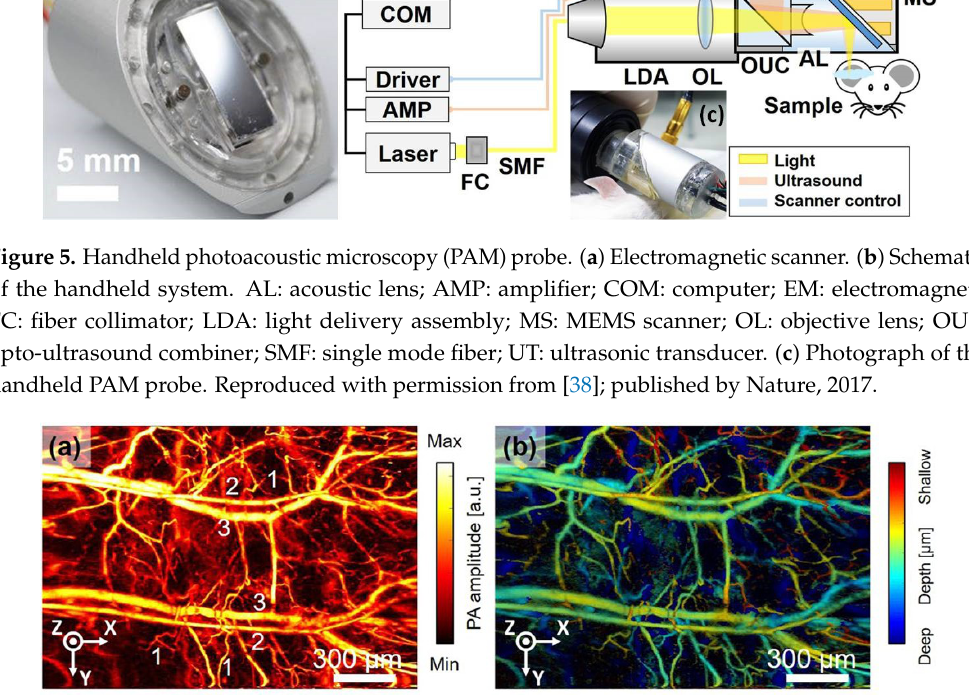
Figure 6. Extension of field-of-view (FOV). ( a ) Single PA MAP image of a mouse ear with an extended FOV (2.8 × 2 mm). ( b ) Depth map image corresponding to PA MAP image ( a ). Reproduced with permission from [38]; published by Nature, 2017.